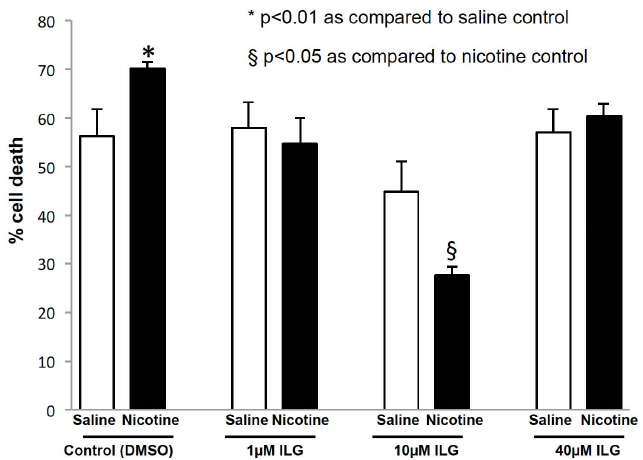
Figure 4. ILG decreases cell death in hippocampal organotypic slice cultures after oxygen-glucose deprivation (OGD). PI fluorescence, which represents cell death, was measured in organotypic brain slices exposed to nicotine or saline treatment, then ILG at varying concentrations 24 h before OGD. Data shown represent cell death normalized to the respective saline groups. To normalize data, the mean of the subgroup was divided by its respective control. PI fluorescence was significantly stronger in the nicotine group than the saline group. PI fluorescence significantly decreased nicotine induced cell death in the nicotine group treated with 10 µM ILG, as compared to the nicotine control. Data are presented mean ± SEM (* p < 0.01, § p < 0.05). n = 4 to 11 per group.